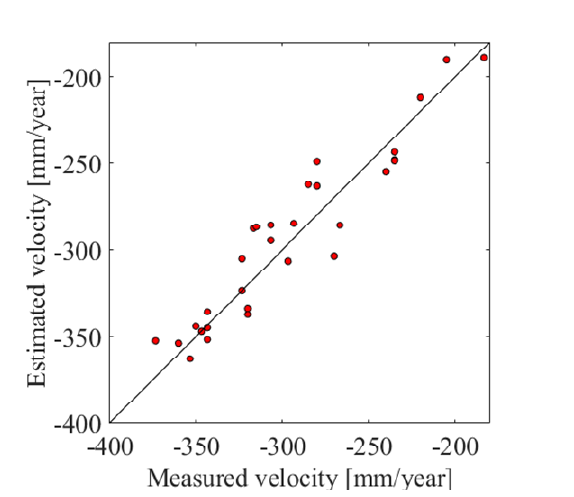
Figure 10. Validation results of vertical components obtained using OLS (Ito et al.,